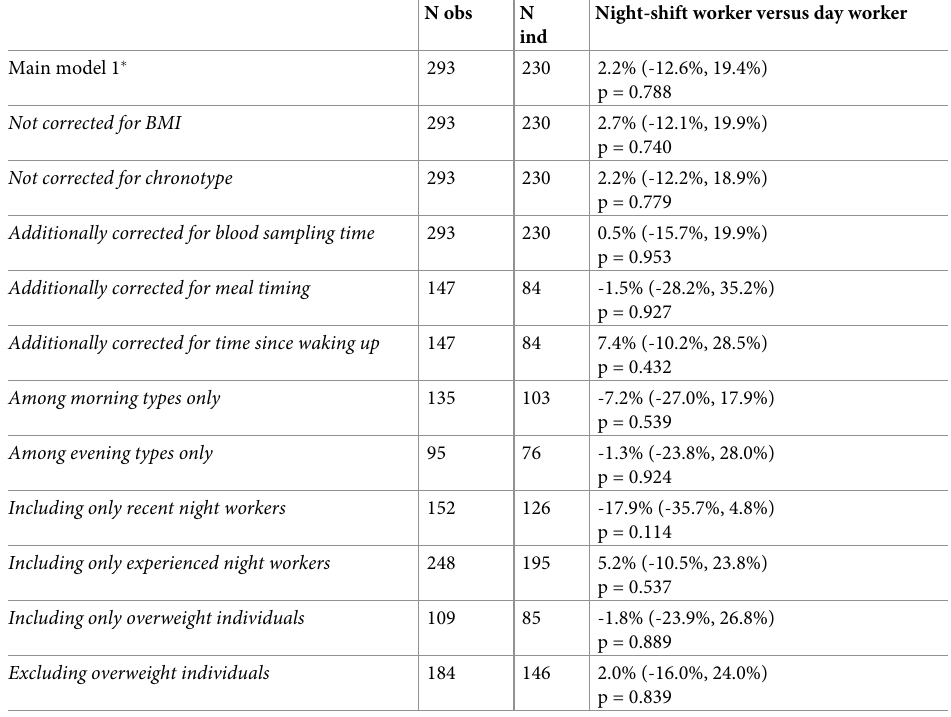
Table 2. Percentage difference between day workers and night-shift workers in sCD36 concentrations in samples collected during a day-shift session.